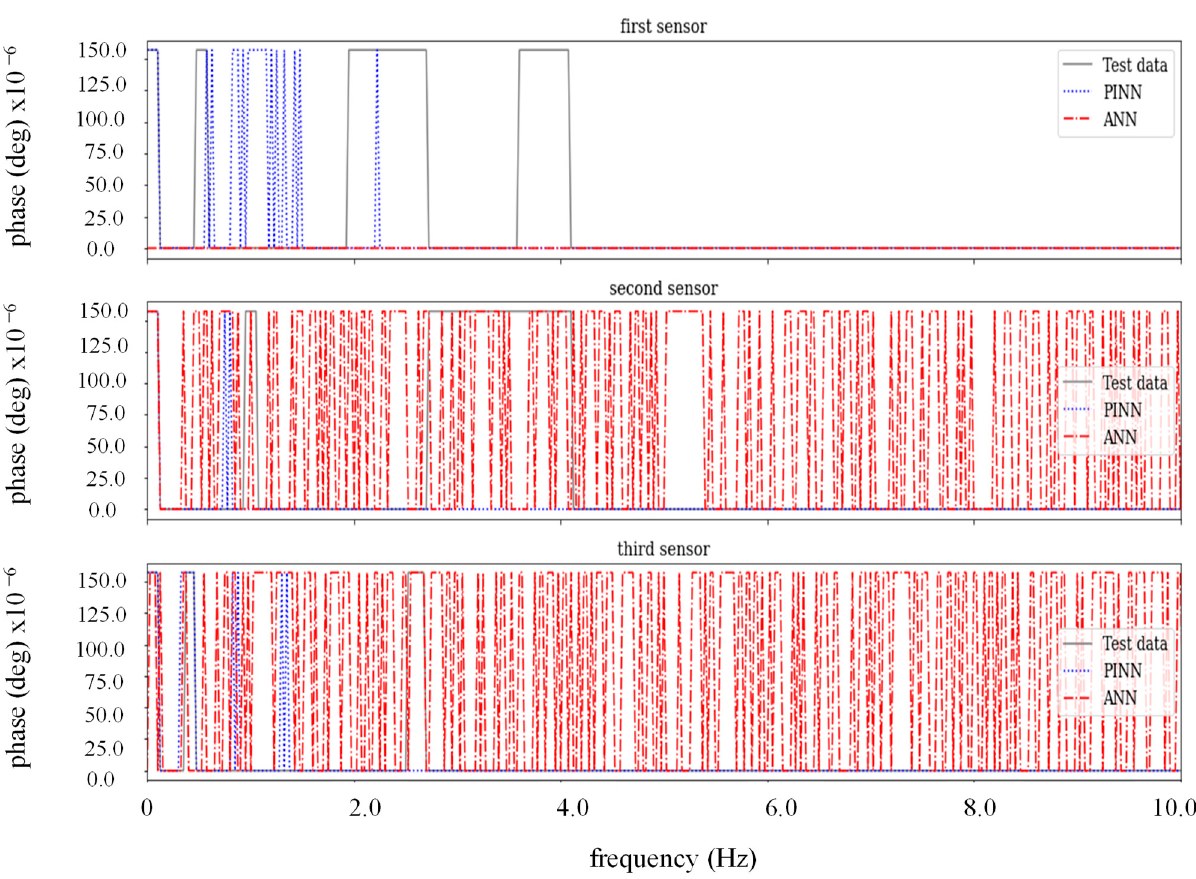
Figure 21. PINN and ANN modal estimation with two hidden layers for the test period.